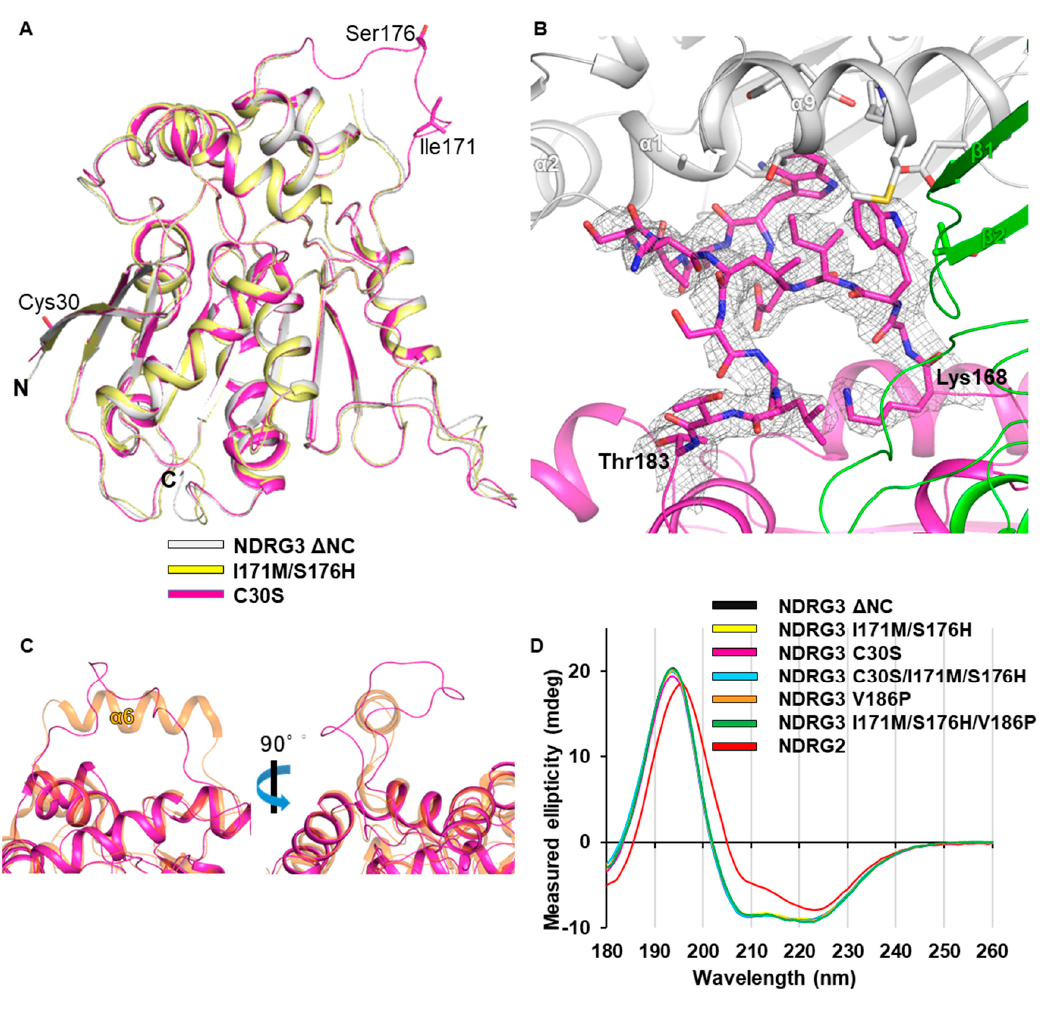
Figure 4. ( A ) Superimposition of the crystal structures of the NDRG3 Δ NC, NDRG3 I171M/S176H, and NDRG3 C30S. Structures of NDRG3 Δ NC, NDRG3 I171M/S176H, and NDRG3 C30S are represented as white, yellow, and magenta cartoon models, respectively. ( B ) Electron density map of the helix α 6 region of NDRG3 C30S mutant. Chain A is represented as a magenta ribbon and residues on the helix α 6 region are shown as stick models with an electron density map. Chain B and chain C of NDRG3 C30S are shown in green and white cartoon models, respectively. The 2mFo-DFc electron density map contoured at 1.5 σ is represented as a grey-colored mesh. ( C ) Structural comparison of the helix α 6 region between NDRG3 C30S and NDRG2. Structures of NDRG3 C30S and NDRG2 are shown in magenta and orange cartoon models, respectively. ( D ) CD spectra of NDRG3 Δ NC, I171M/S176H, C30S, C30S/I171M/S176H, V186P, I171M/S176H/V186P, and NDRG2.